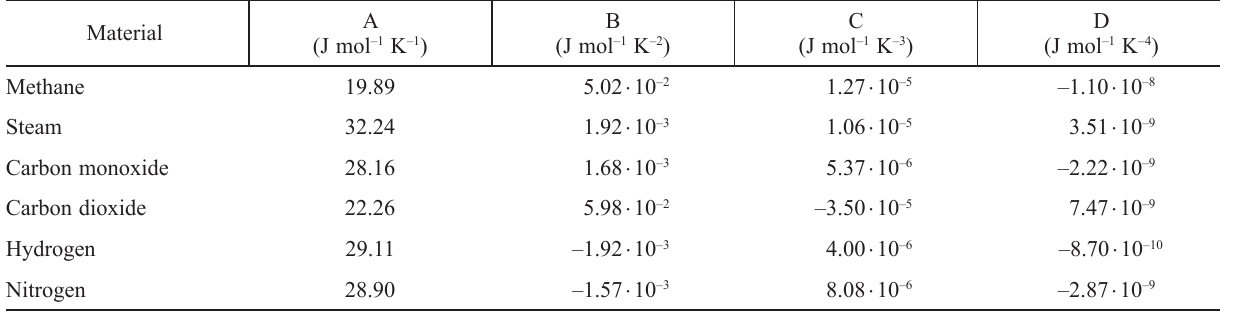
Table 2 – Molar heat constants 41